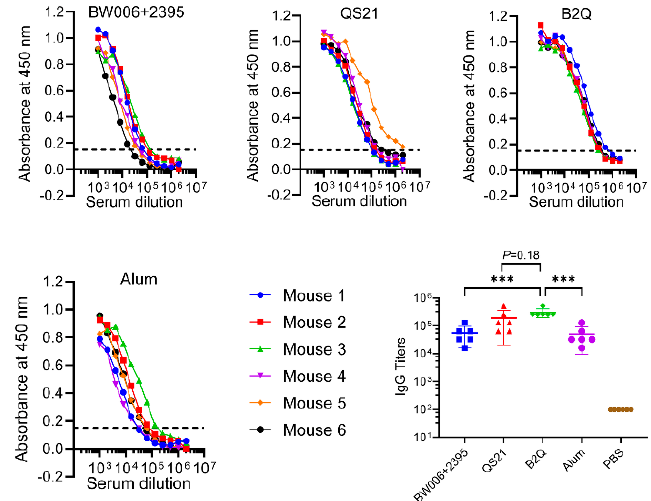
Figure 1. Humoral responses of mice in the adjuvant synergy study. For enzyme-linked immunosorbent assay (ELISA) analysis of each serum sample from immunized mice, the horizontal coordinate is the fold change in the serum dilution, and the vertical coordinate is the absorbance value measured at 450 nm. The dashed lines (OD 450 = 0.15) were set as the cutoff signal for the values of IgG titers. For statistical analysis, each dot represents data from a single mouse, N = 6. Data are shown as the mean ± standard deviation (SD) and were analyzed by one-way analysis of variance (ANOVA), with the mean of the B2Q group used as a control. *** p ≤ 0.001.